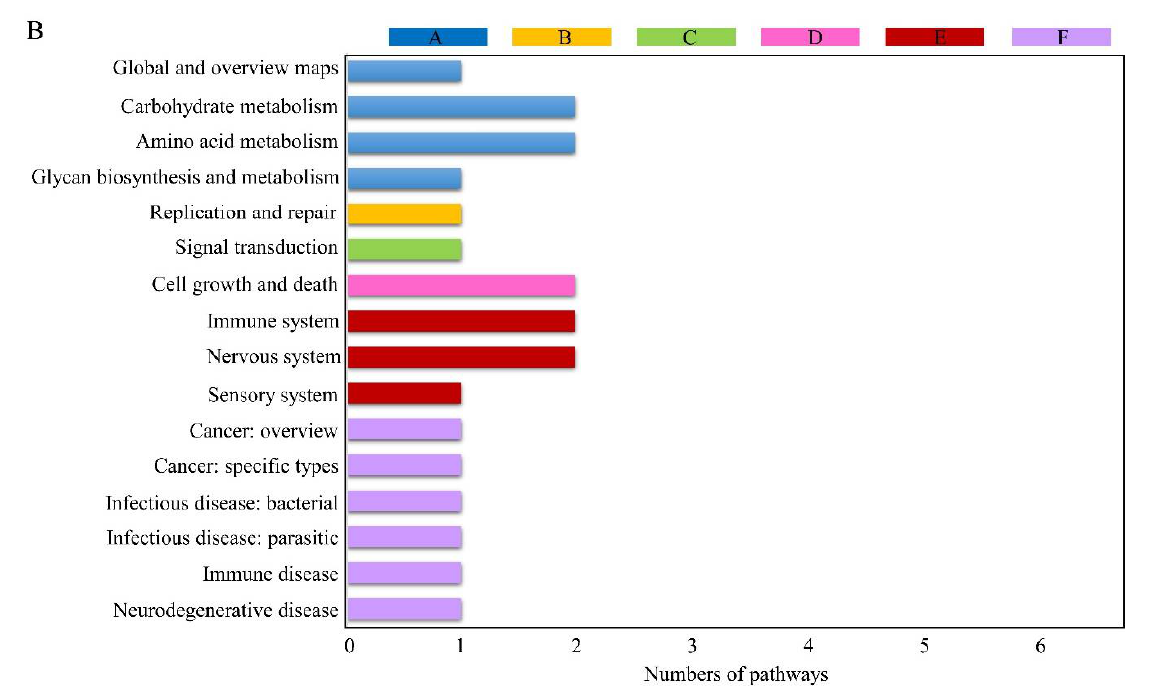
Figure 3. KEGG (Kyoto Encyclopedia of Genes and Genomes) assembled unigenes from chlorophyl- lides composites treatments. ( A ) MCF-7 cells; ( B ) MDA-MB-231 cells. The results were classified into six categories: A. metabolism; B. genetic information processing; C. environmental information pro- cessing; D. cellular processes; E. organismal systems; and F. human diseases. The y -axis is classification of KEGG, and the x -axis is the corresponding numbers of pathways. p <